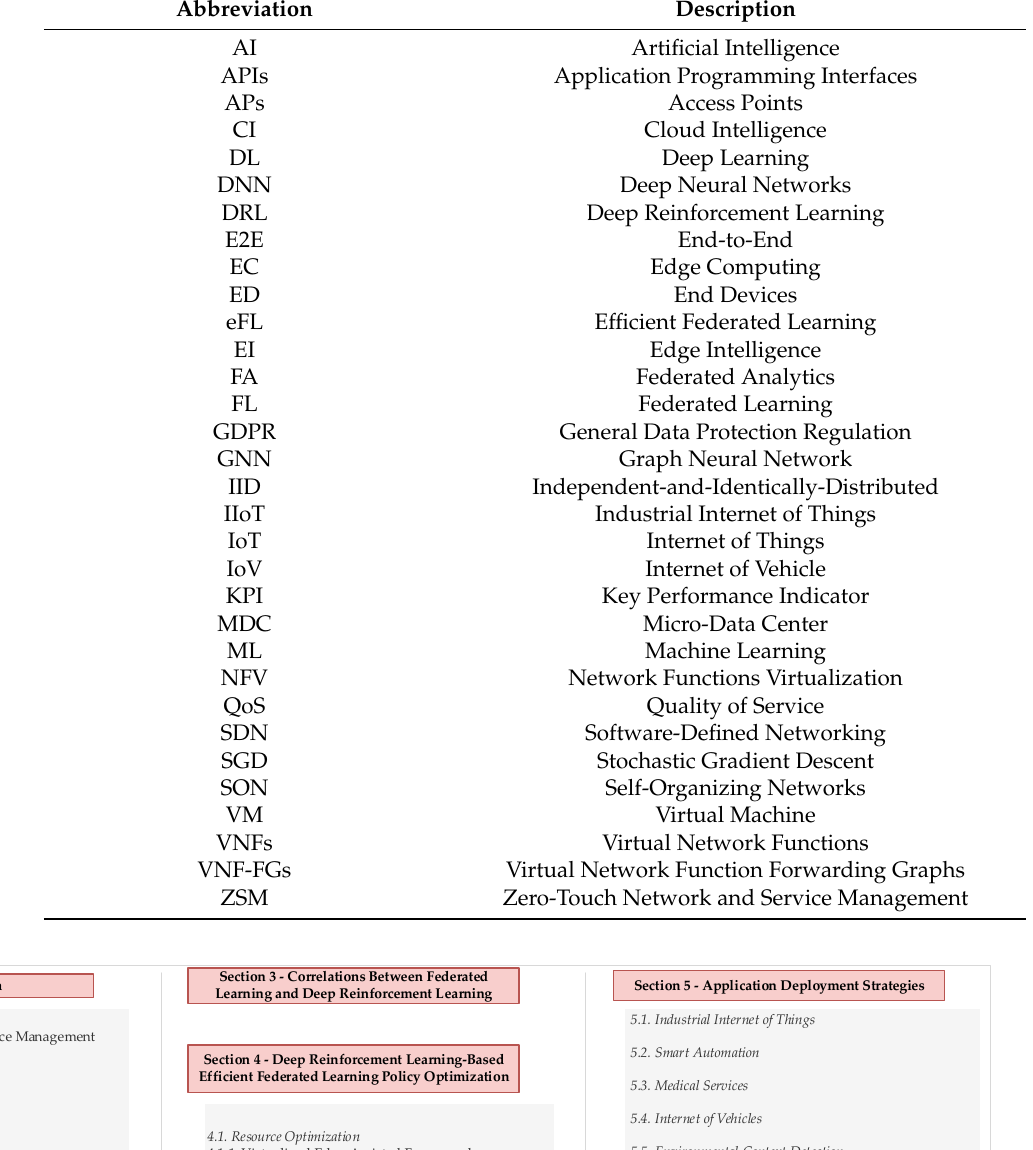
Table 1. List of Important Acronyms.